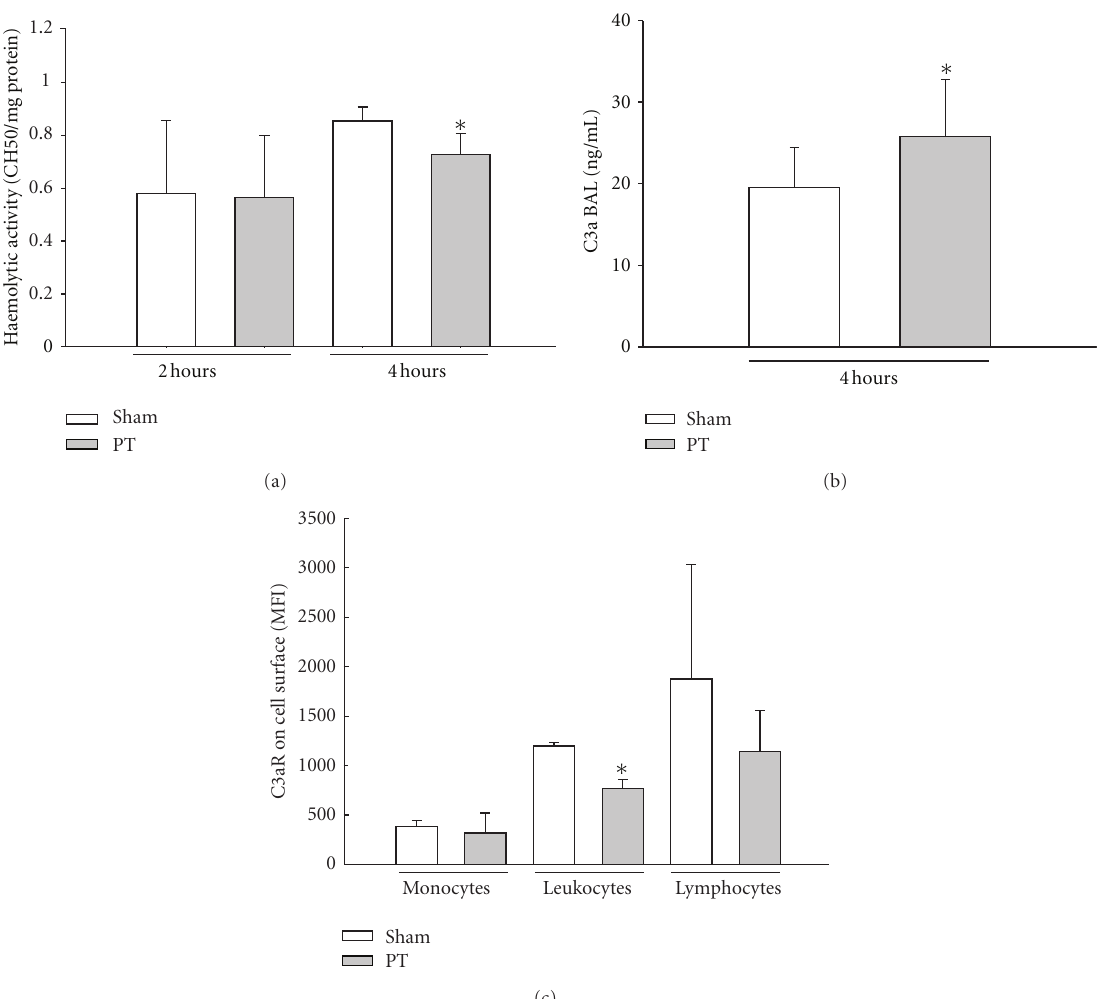
Figure 4: Systemic complement response after trauma, (a) presents the hemolytic activity (CH50/mg) on Sham- and PT-rats 2 and 4hrs after trauma, (b) the C3a (ng/mL) BAL-Fluid levels in Sham- versus PT-rats 2 and 4hrs post trauma and (c) the C3aR Expression (MFI) on Monocytes, Neutrophils and Lymphocytes in Sham- and PT-rats 4hrs after trauma. All data are presented as mean ± SD. ∗ P < 0 . 05. n = 6–10